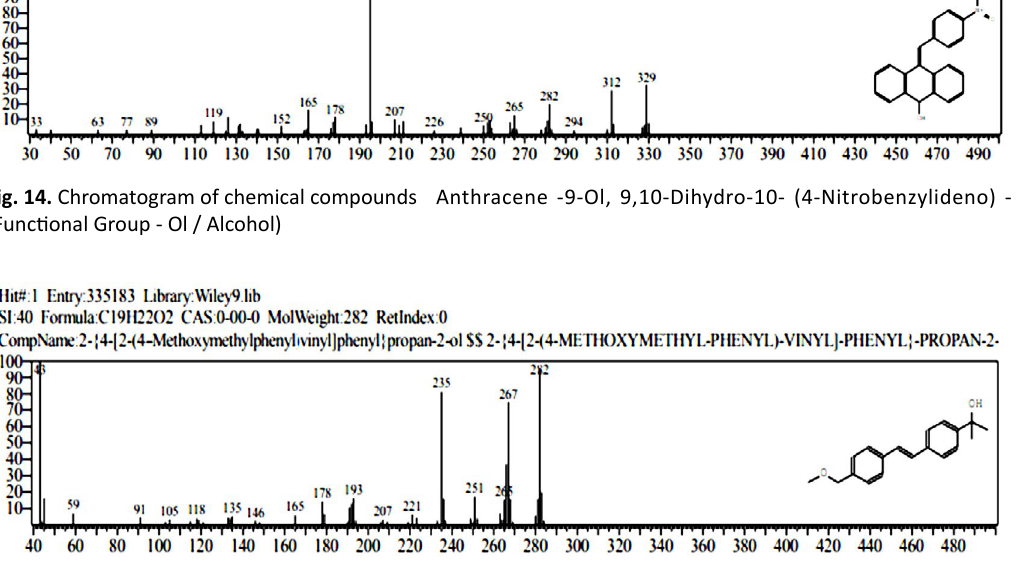
Fig. 15. The chromatogram of chemical compounds 2- {4-[2-(4-Methoxymethylphenyl) vinyl] phenyl} propan-2-ol (functional group –ol/alhohol)